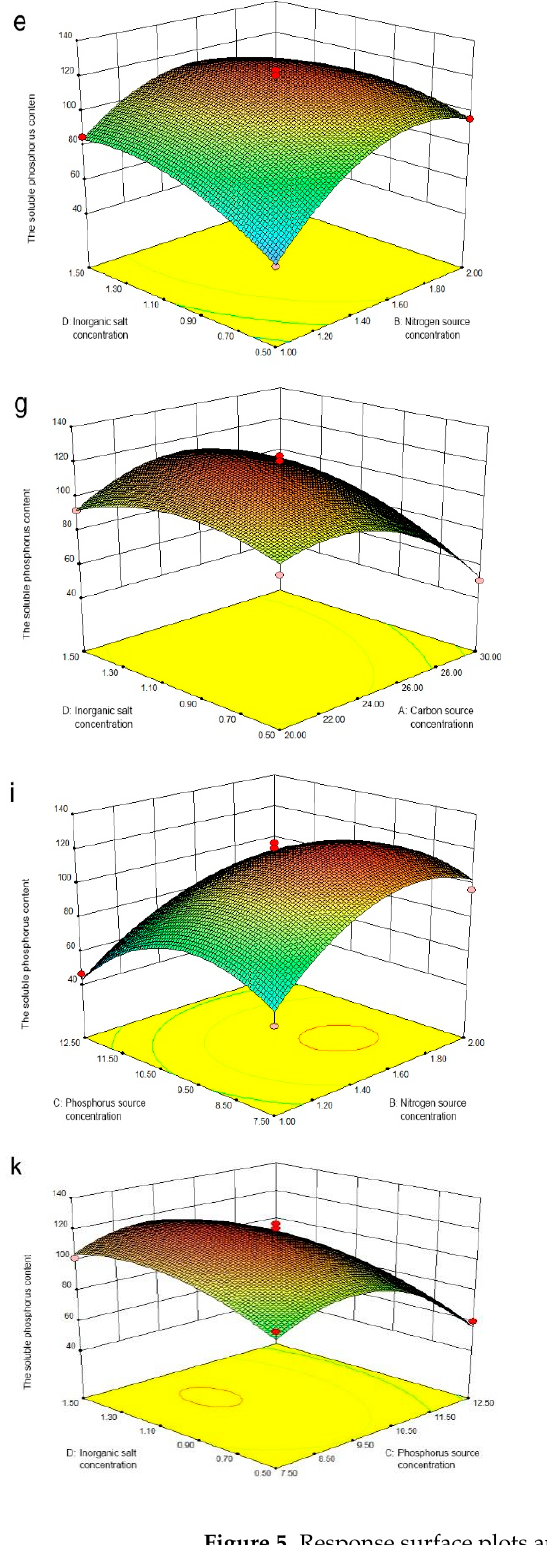
Figure 5. Response surface plots and contour lines of effects for the interaction between factors for the phosphate-solubilizing capacity of PSF7. ( a ) Response surface plots of factor AB. ( b ) Contour line of factor AB. ( c ) Response surface plots of factor AC. ( d ) Contour line of factor AC. ( e ) Response surface plots of factor BD. ( f ) Contour line of factor BD. ( g ) Response surface plots of factor AD. ( h ) Contour line of factor AD. ( i ) Response surface plots of factor BC. ( j ) Contour line of factor BC. ( k ) Response surface plots of factor CD. ( l ) Contour line of factor CD.